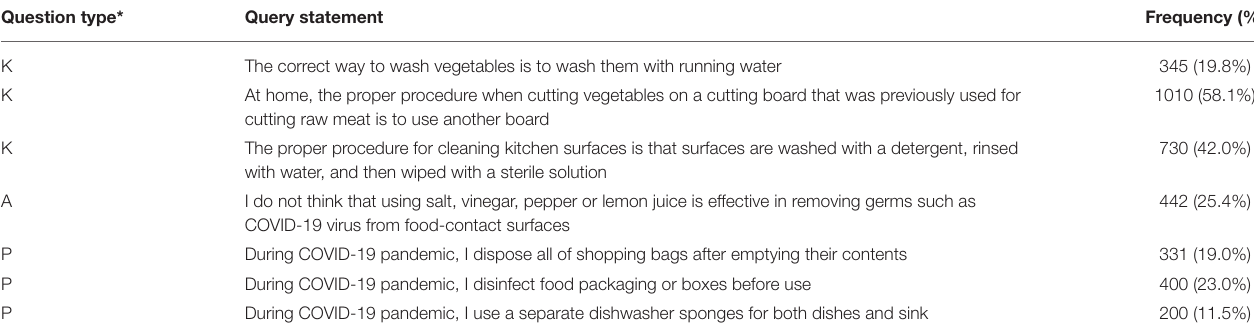
TABLE 4 | Query statements and responses of “cross-contamination prevention/disinfection procedures”